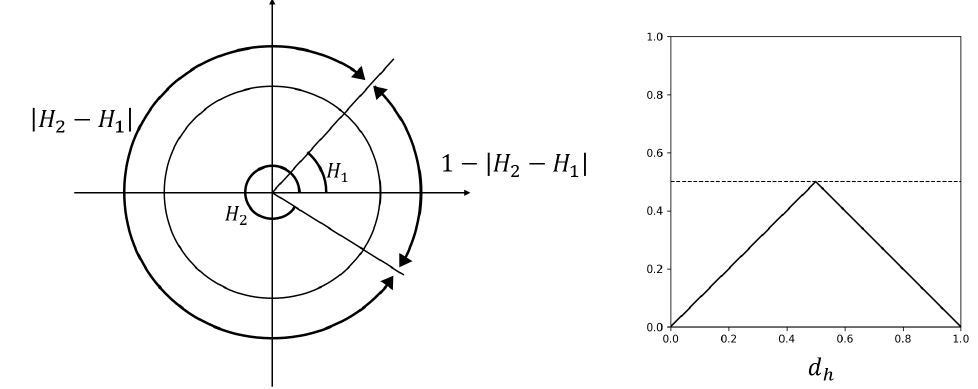
Figure 4. ( left ) Wrap-around distance loss ( d h ( H 1 , H 2 ) ). ( right ) Plot of d h